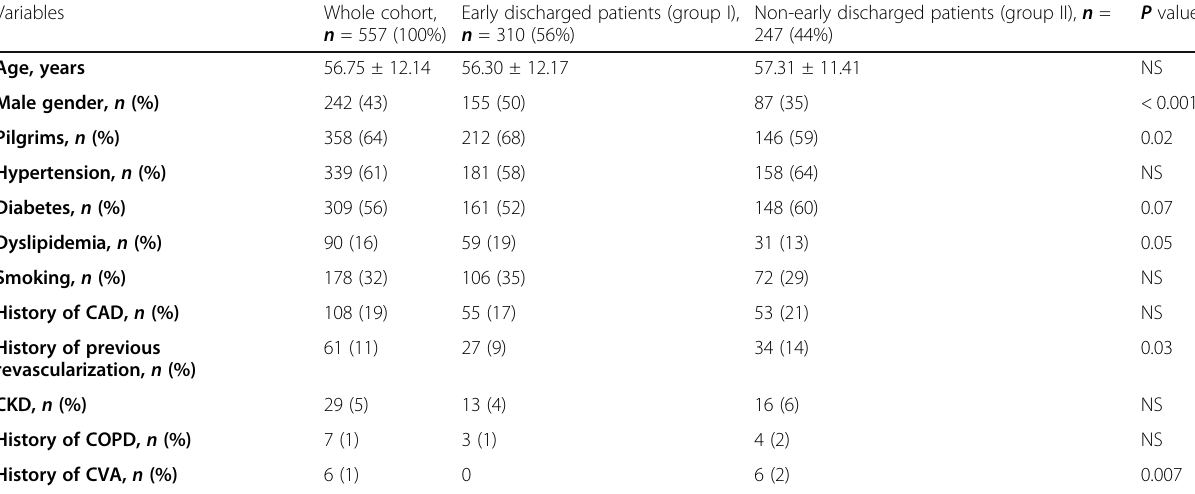
Table 1 Baseline demographics and risk factors in the whole cohort and comparison of early discharge group versus non-early discharge group